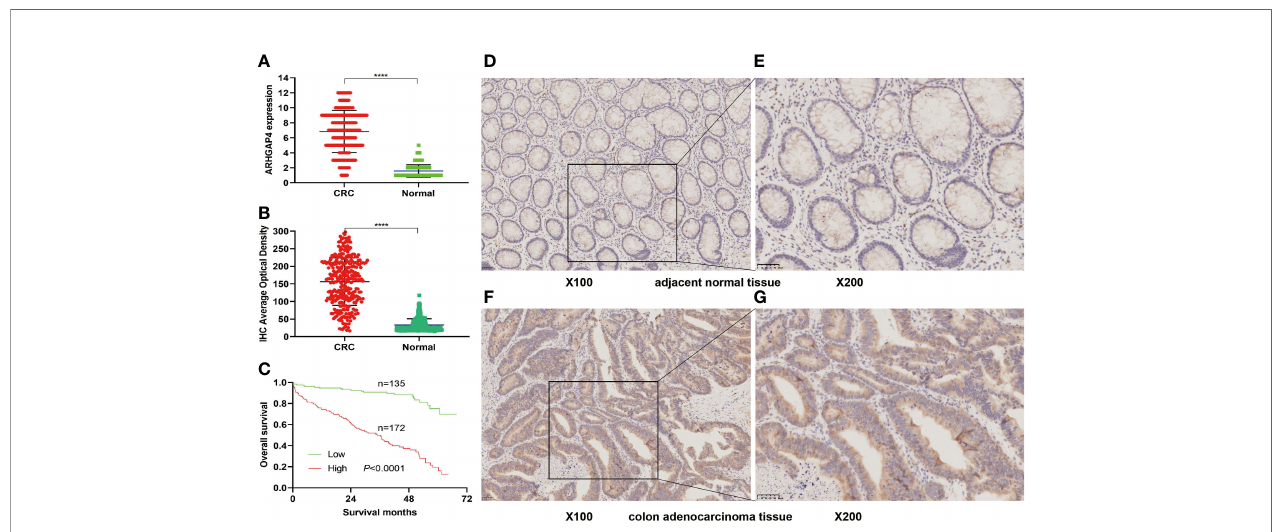
FIGURE 5 | ARHGAP4 expression and prognosis in clinical colorectal cancer (CRC). (A) Comparison of ARHGAP4 in CRC tissues and in normal tissues by two pathologists. (B) Comparison of ARHGAP4 in CRC tissues and in normal tissues performed quantitative analysis by ImageJ. (C) The relationship between ARHGAP4 expression and OS in CRC. (D, E) ARHGAP4 is lowly expressed in normal tissues adjacent to CRC. (F, G) ARHGAP4 is highly expressed in CRC tissues. ****Indicates that the P value is less than 0.0001.